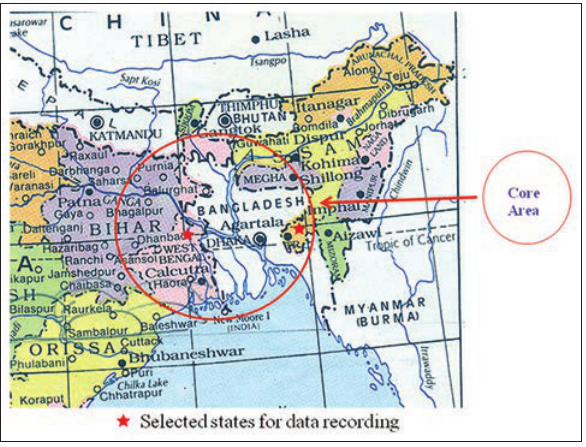
Figure-1: Breeding tract of meat-type, prolific Indian Black Bengal goats.